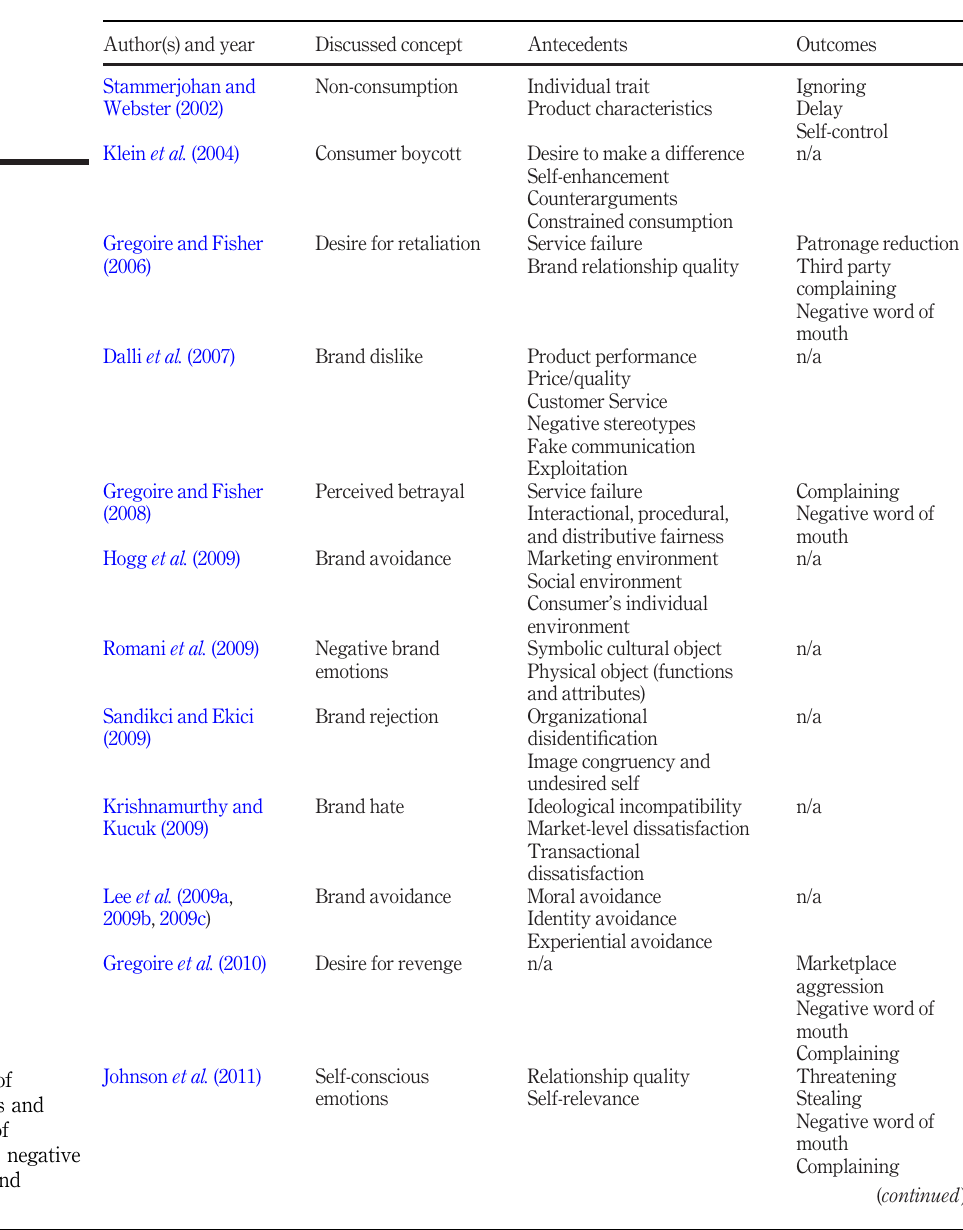
Table AI. Summary of antecedents and outcomes of consumers ’ negative emotions and